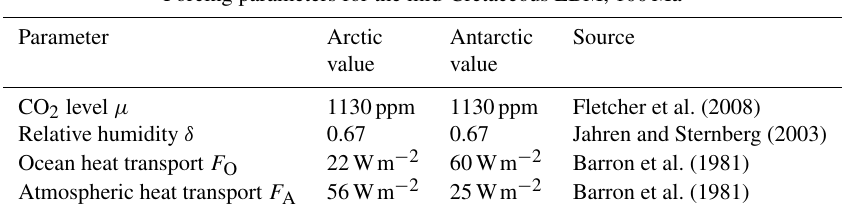
Table 3. Summary of parameters used in the polar mid-Cretaceous model. The main difference in Cretaceous climate between the two poles was that ocean heat transport was much higher in the Antarctic. Parameters not listed here are the same as in Table 1. The values of F A and F O shown here are estimated from Barron et al. (1981).